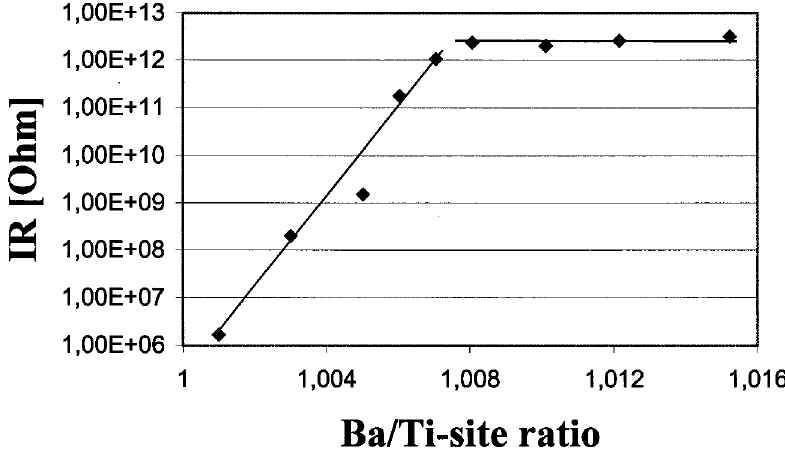
FIGURE 7 Insulation resistance at 140 (cid:1) C of ceramic disc